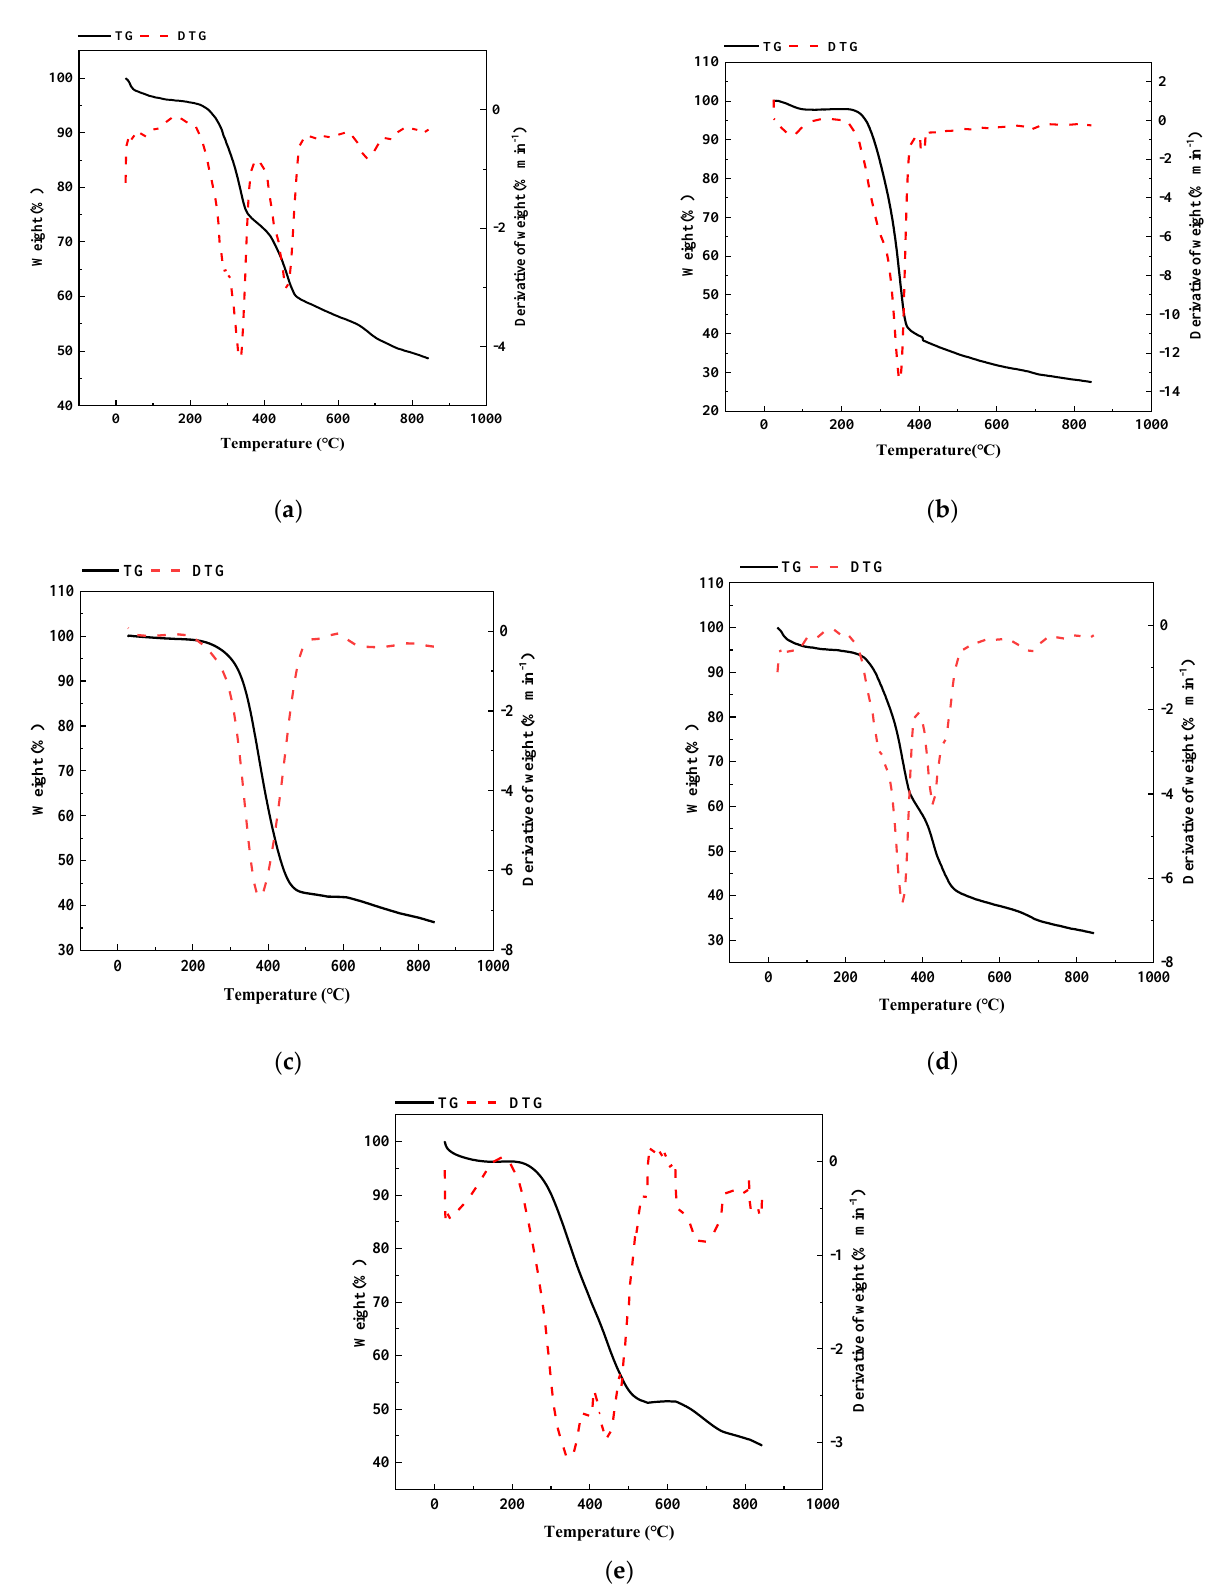
Figure 2. Thermal gravity (TG) and differential TG (DTG) curves of ( a ) HR, ( b ) ISW1, ( c ) ISW2, ( d ) HR and ISW1, ( e ) HR and ISW2.